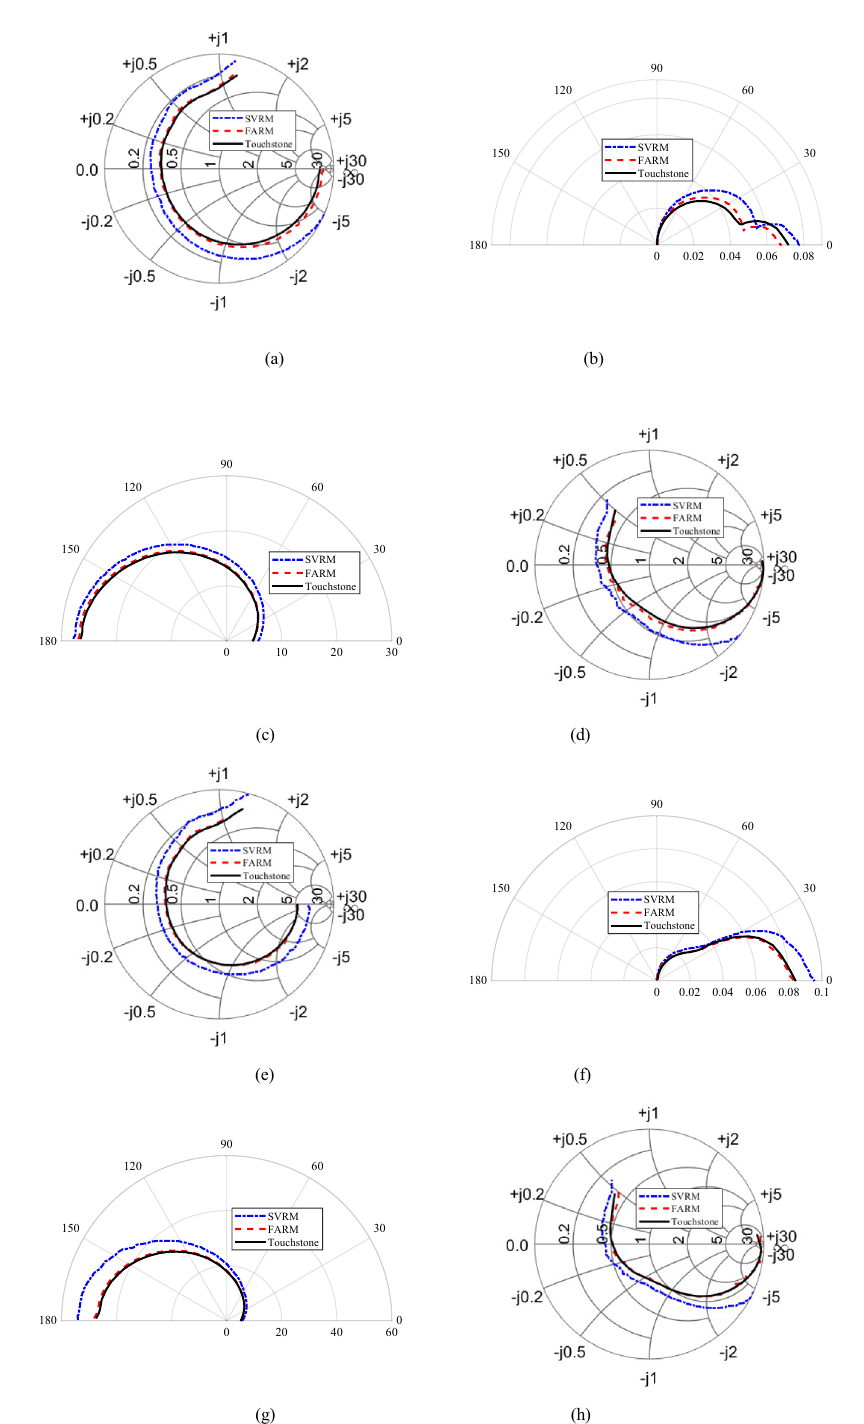
Figure 5. Transistor BFP 720ESD: Smith chart (for reflection coefficient) and polar graphs (for transmission coefficient) of ( a – d ) S 11 , S 12 S 21 , S 22 at bias voltage V = 2.5 V and bias current I = 10 mA, ( e – h ) S 11 , S 12 S 21 , S 22 at V = 4 V and I = 25